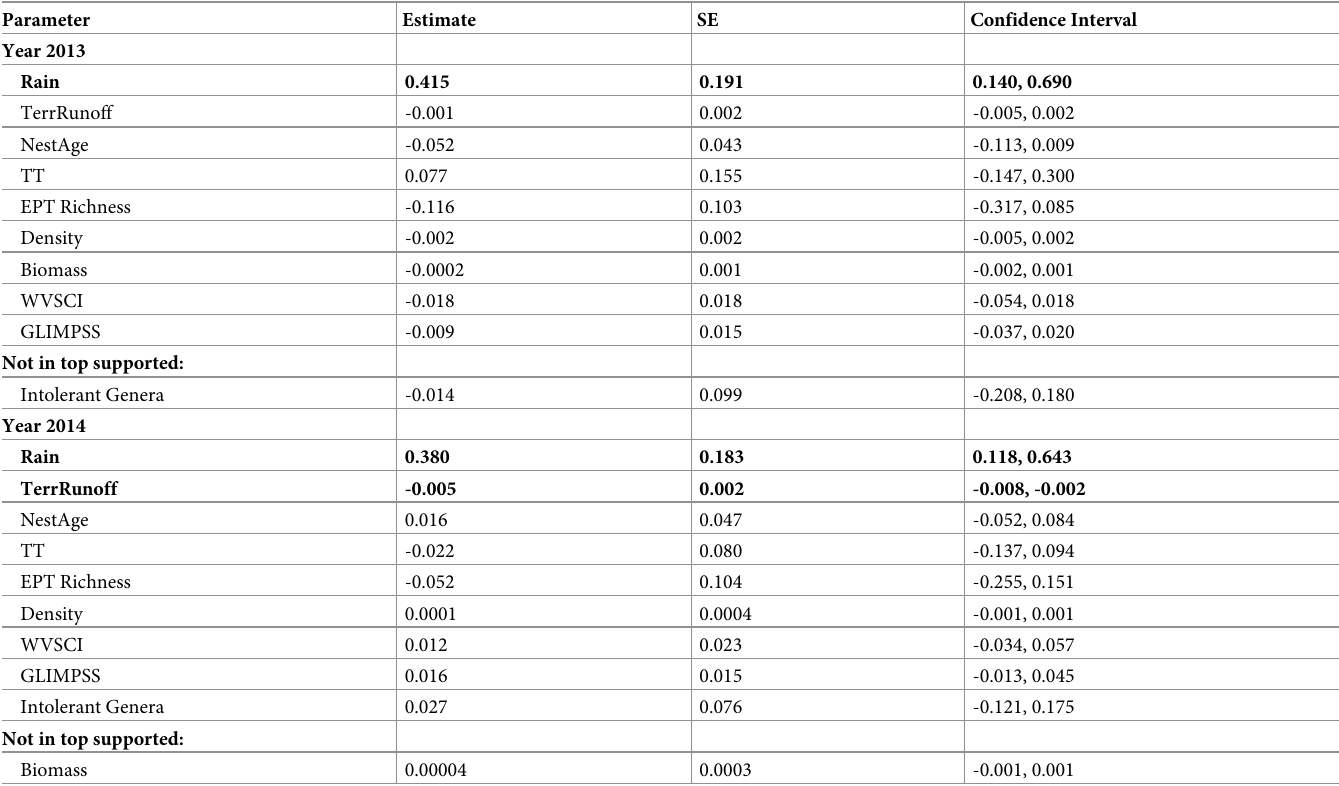
Table 6. Annual waterthrush nest survival covariates found in the top supported ( Δ AICc < 2, n = 6) and unsupported (n = 1) AICc models based on regression coef- ficients, standard error (SE), and 85% confidence intervals. In the null base model Rain had positive influence on daily survival rate (DSR) in 2013 and 2014, while Terr- Runoff had negative influence on nest survival in 2014. Significant covariates with non-overlapping confidence intervals are bolded. Covariates included in every model to account for their influence (i.e., Rain, NestAge, TT, and TerrRunoff; [28]) have model-averaged regression coefficients and unconditional SEs. Variable names are defined in S2